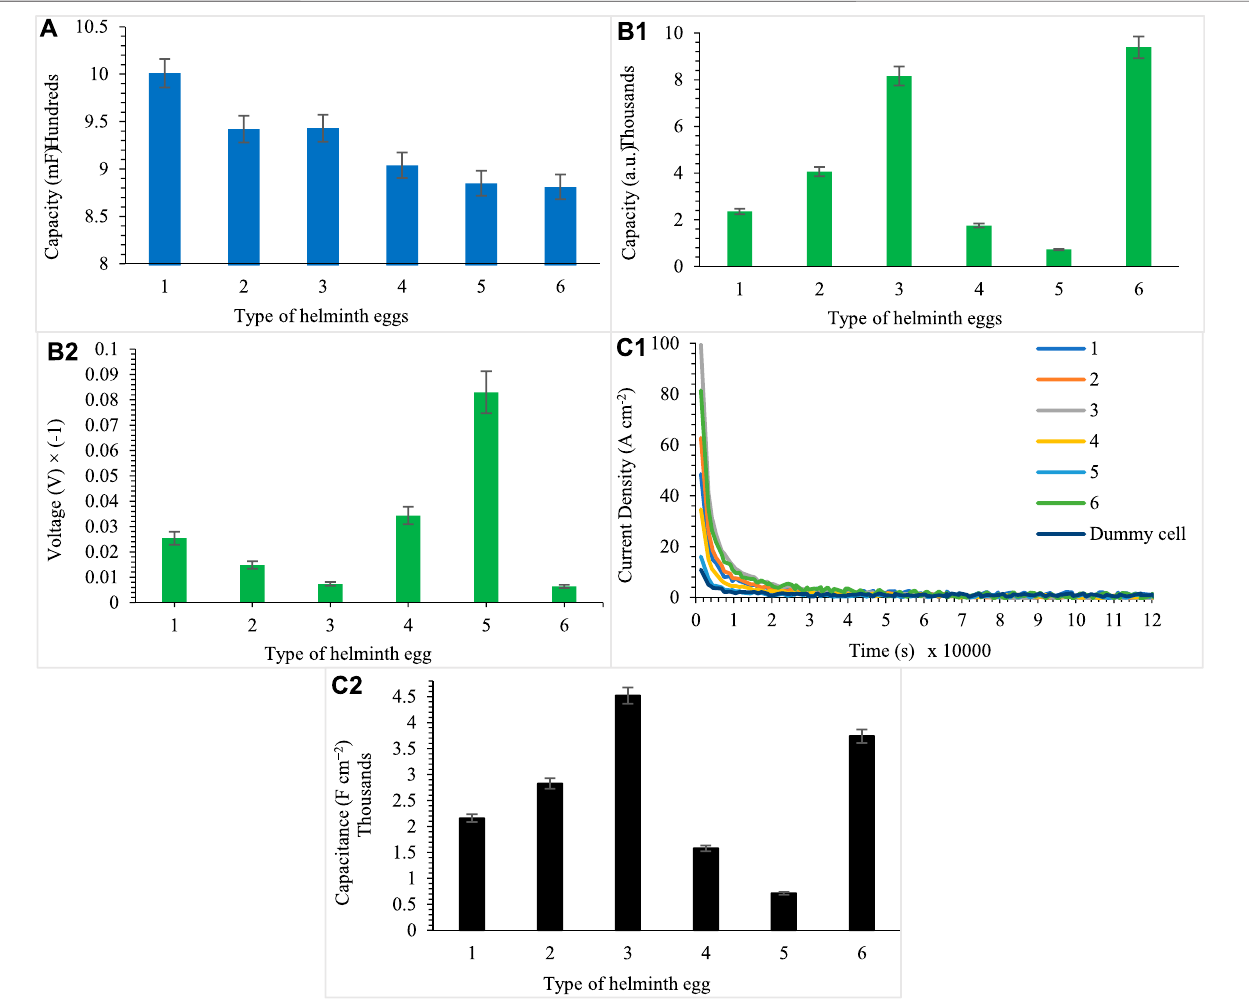
FIGURE2|(A) Determinationbymultimeter, (B) determinationbyOp-Amp(integration)(b 1 ,b 2 ),and (C) currentdensityofhelmintheggs,capacityperarea(c 1 ,c 2 ), for fi ve independent repeats during implanting ofthree microelectrodeswith 0.0124 ± 0.0008 mm inter-electrode distance, error bar: ± standard deviation ( n (cid:2) 5). Note that to prevent clutter, error bars are eliminated in part (c 1